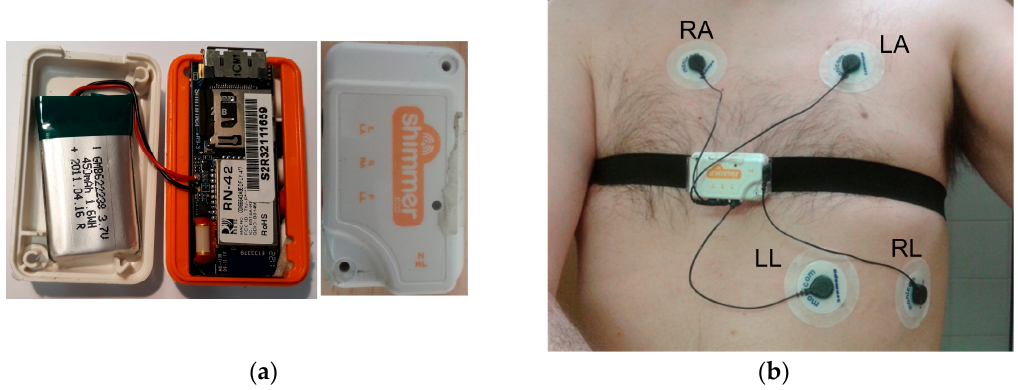
Figure 1. Shimmer electrocardiogram (ECG) sensor: ( a ) Shimmer ECG module; ( b ) Positions of the electrodes of the ECG sensor.